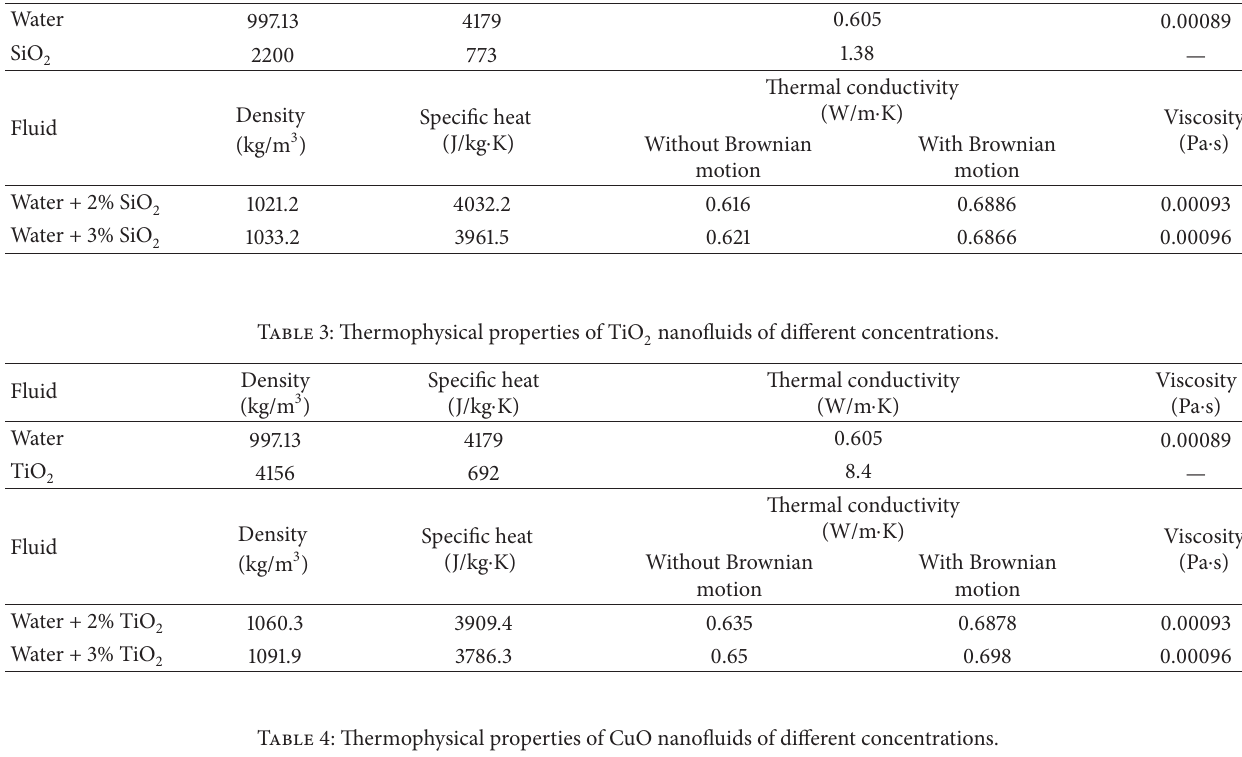
Table 2: Thermophysical properties of SiO